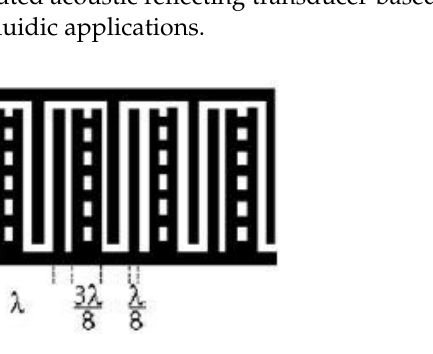
Figure 15. Schematic representation of the dispersive delay line electrode configuration [153].